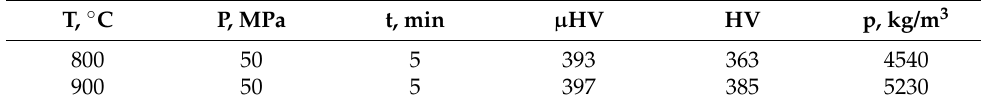
Table 4. Parameters of the studied samples and their preparation.